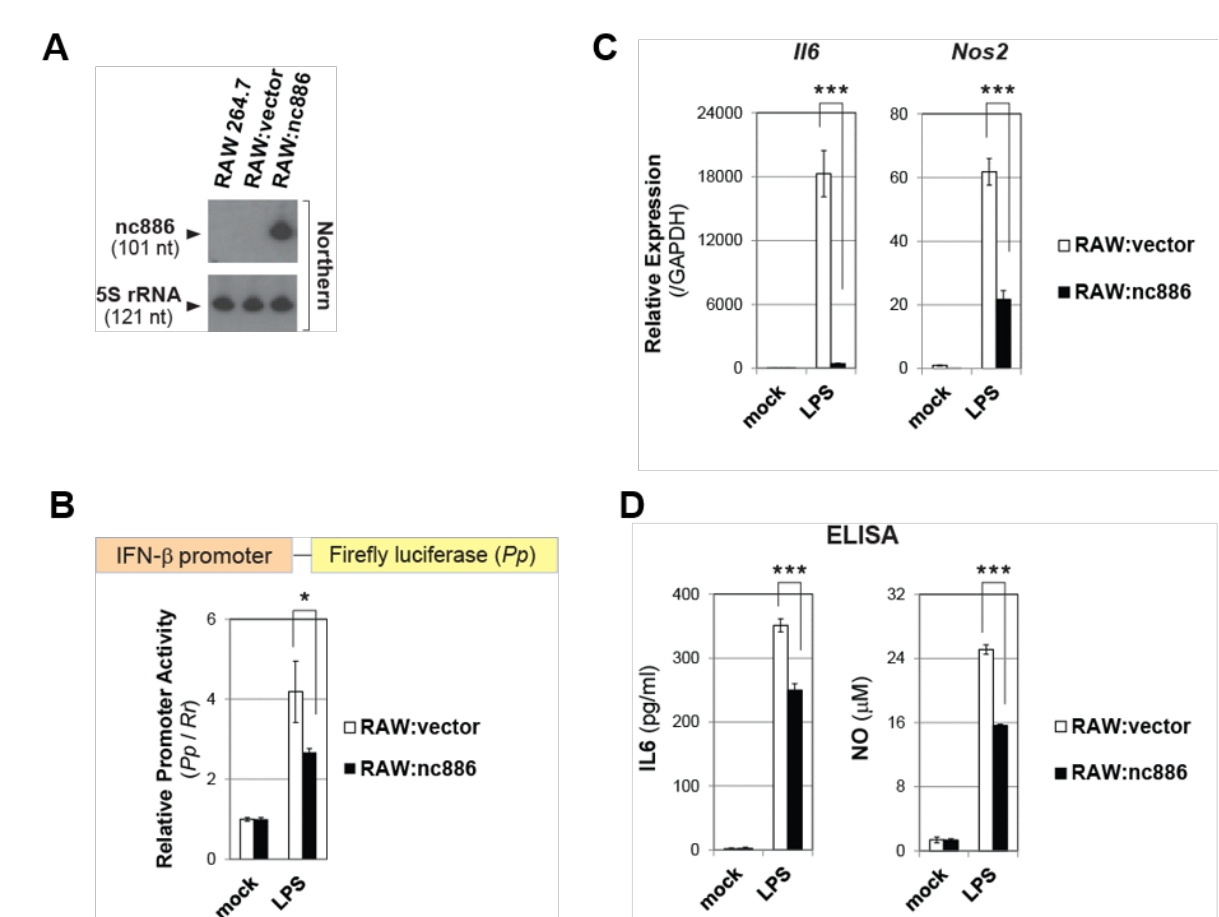
Figure 5. nc886 attenuates inflammatory responses in macrophages triggered by LPS. ( A ) Northern hybridization of nc886 and 5S rRNA as a loading control. ( B ) Luciferase assays. Transfection of luciferase plasmids at 0 h, treatment of LPS (10 ng/mL) at 6 h, and cell harvest and luciferase assays at 24 h. All other descriptions are the same as Figure 1D. ( C ) qRT-PCR of indicated genes at 6 h after treatment with LPS (100 ng/mL). ( D ) ELISA to measure secreted IL6 and NO, at 24 h after treatment with LPS (100 ng/mL). One asterisk designates a p -value less than 0.05; Three asterisks designate a p -value less than